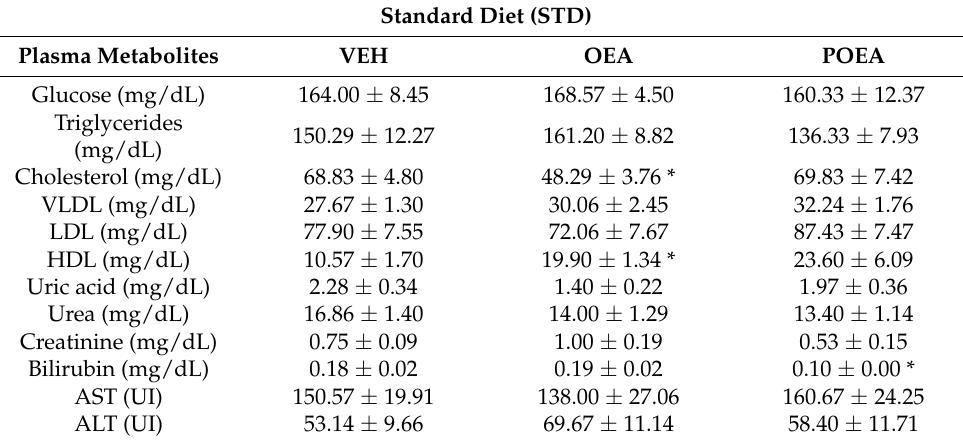
Table 2. Plasma biochemical parameters from animals fed STD and treated with either OEA or POEA (10 mg/kg) for 15 days.